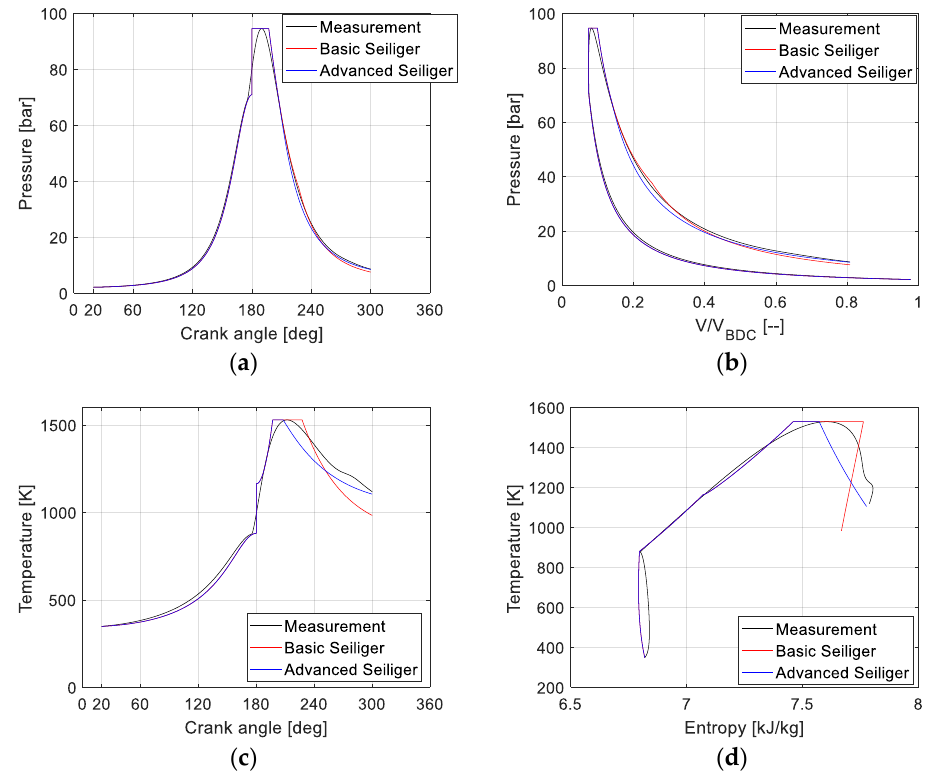
Figure 10. Comparison of basic and advanced Seiliger process models: ( a ) p - ϕ diagram; ( b ) p - V diagram; ( c ) T - ϕ diagram; ( d ) T - s diagram.